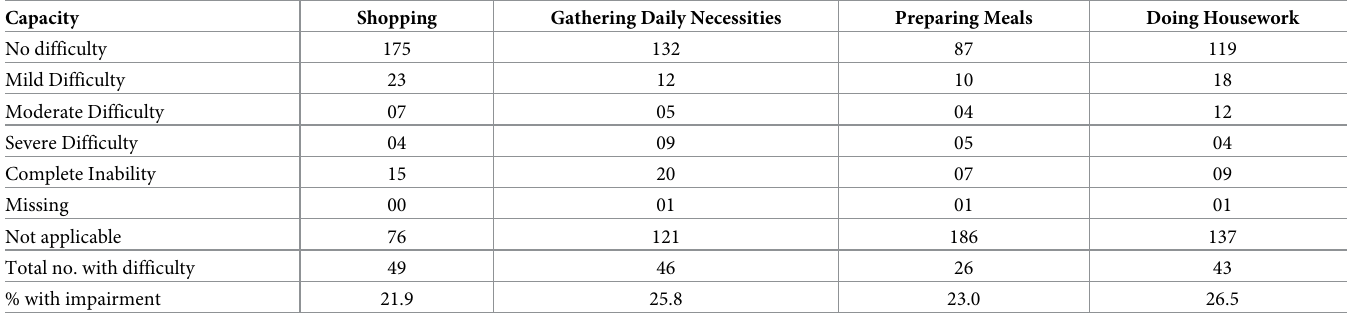
Table 6. Difficulties in domestic life activities.